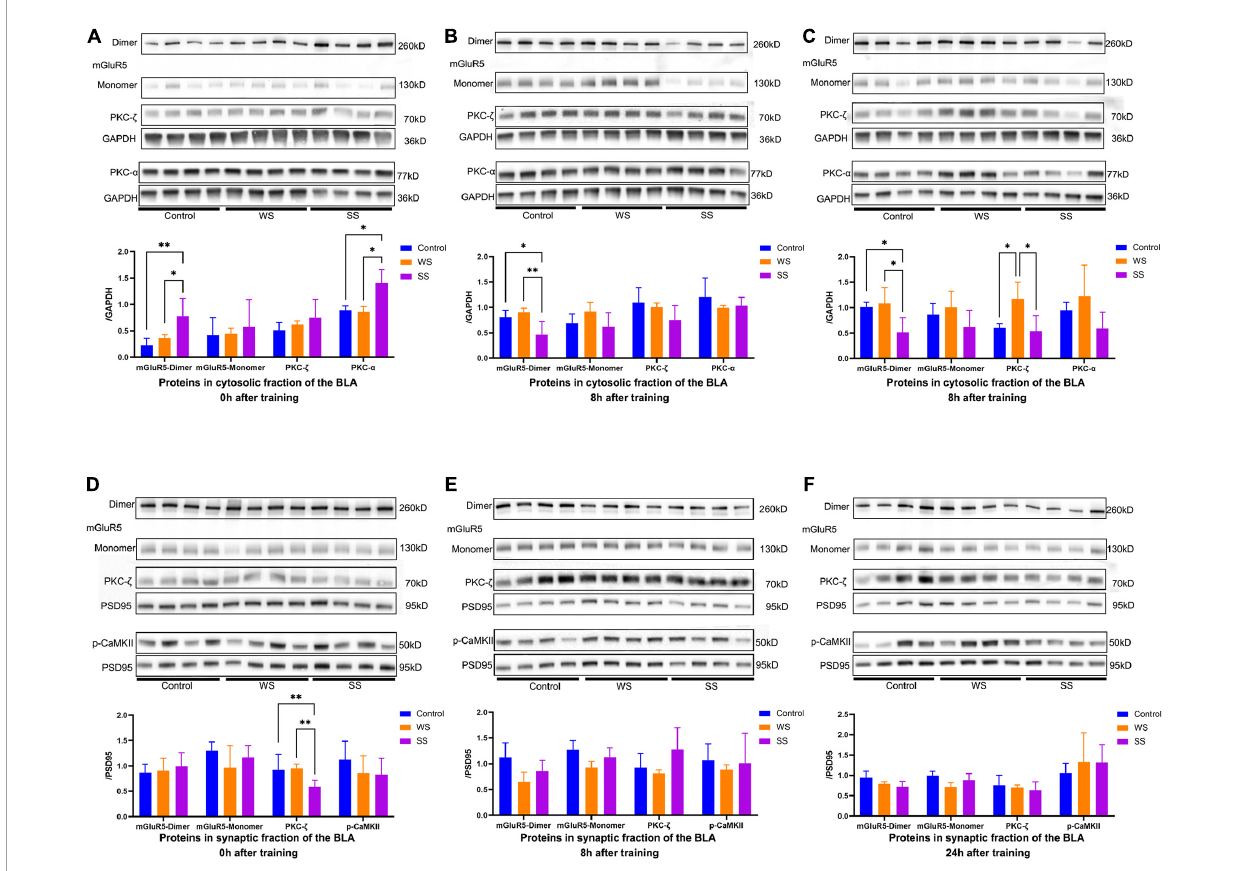
FIGURE4 mGluR5-dimer and PKC- α expression in the amygdala of mice at different time point after fear conditioning. (A) mGluR5-dimer and PKC- α expressions were increased in the cytosolic fraction of amygdala from SS group in immediately after fear conditioning but S2 mGluR5-monomer and PKC- ζ expressions were not affected by fear conditioning (0 h, one-way ANOVA, mGluR5-dimer, F 2 , 9 = 6.988, p = 0.0147, multiple comparison, Fisher’s LSD test, p [ Control vs WS ] = 0.3991, ∗∗ p [ Control vs SS ] = 0.0059, ∗ p [ WS vs SS ] = 0.0243; mGluR5-monomer, F 2 , 9 = 0.2094, p = 0.8149; PKC- ζ , F 2 , 9 = 1.072, p = 0.3824; PKC- α , F 2 , 9 = 14.17, p = 0.0017, multiple comparison, Fisher’s LSD test, p [ Control vs WS ] = 0.7988, ∗ p [ Control vs SS ] = 0.015, ∗ p [ WS vs SS ] = 0.0011). (B,C) mGluR5-dimer expression was decreased in the S2 fraction of the amygdala from SS group 8 h and 24 h after fear conditioning but S2 mGluR5-monomer, PKC- ζ and PKC- α expressions in WS and SS group were consist with control group (B) , 8 h, one-way ANOVA, mGluR5-dimer, F 2 , 9 = 6.823, p = 0.0157, multiple comparison, Fisher’s LSD test, p [ Control vs SS ] = 0.4347, ∗ p [ Control vs SS ] = 0.024, ∗∗ p [ WS vs ζ , F α , F SS ] = 0.0064; mGluR5-monomer, F 2 , 9 = 2.121, p = 0.1759; PKC- 2 , 9 = 2.151, p = 0.1723; PKC- 2 , 9 = 0.8745, p = 0.4497. (C) 24 h, one-way ANOVA, mGluR5-dimer, F 2 , 9 = 6.114, p = 0.0210, multiple comparison, Fisher’s LSD test, p [ Control vs WS ] = 0.6839, ∗ p [ Control vs SS ] = 0.0208, ∗ p [ WS